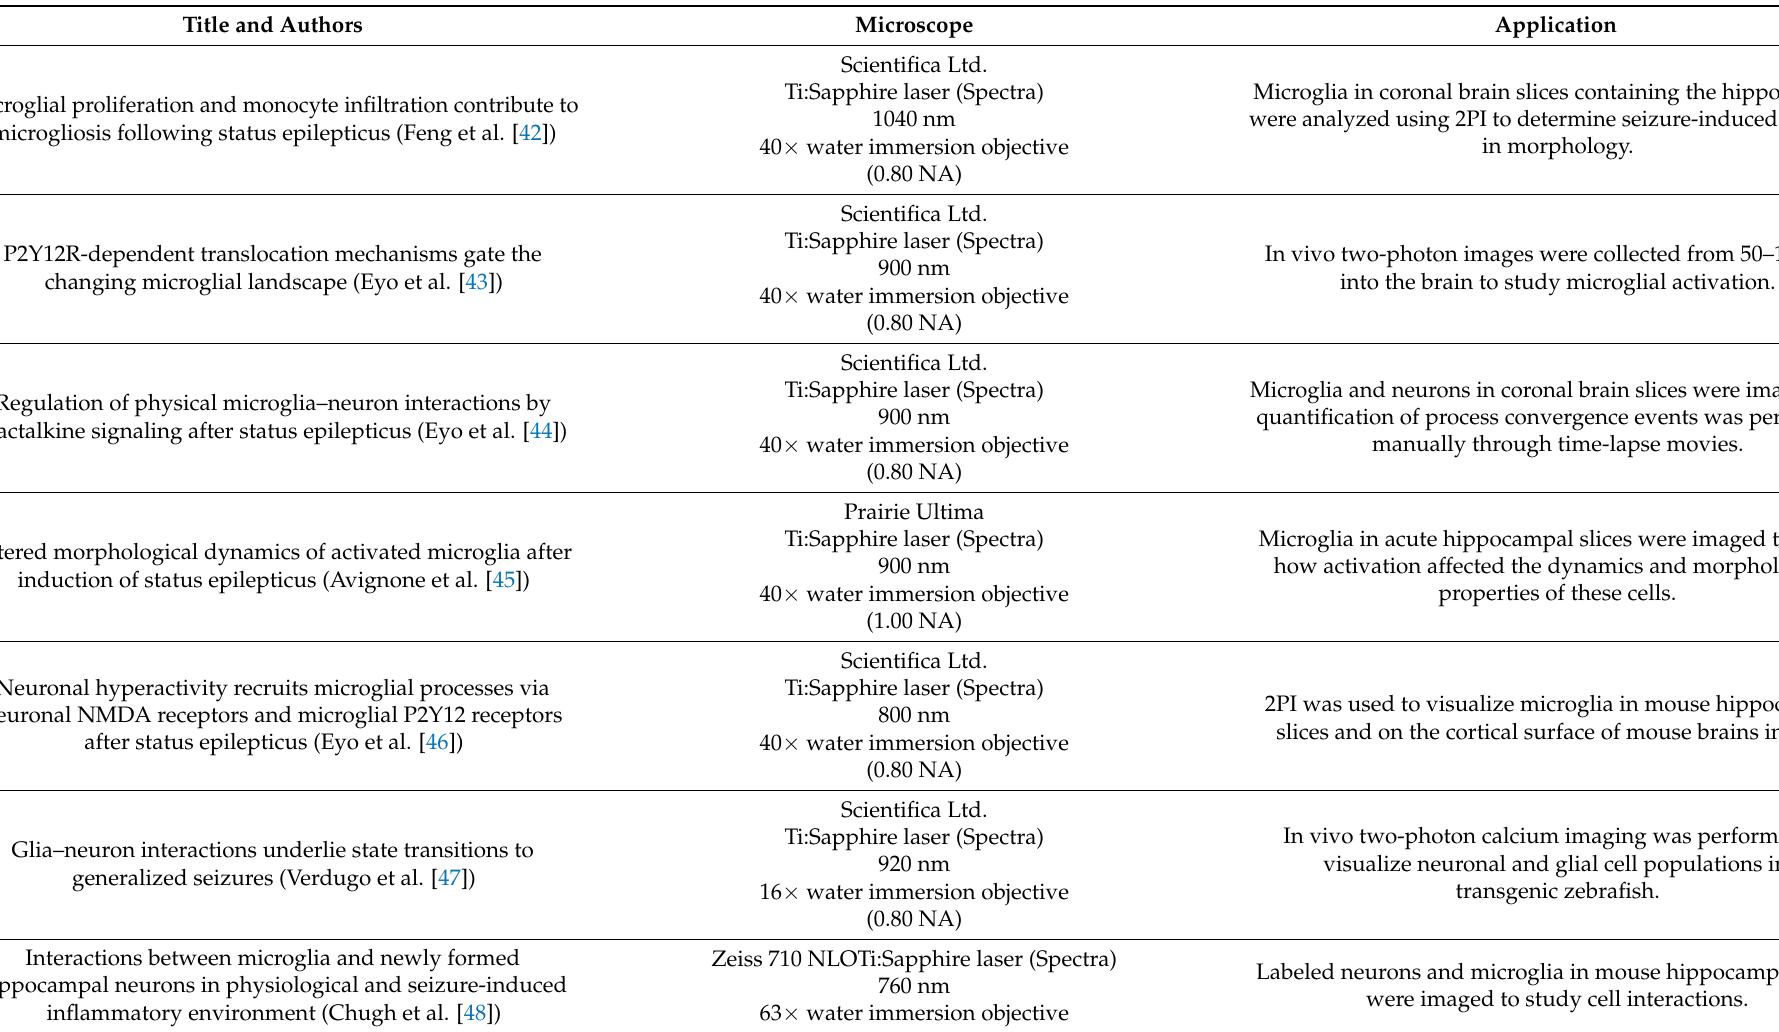
Table 2. Microglia—data abstraction table catalogues the type of two-photon microscope used and how 2PI was applied in each study within this group of